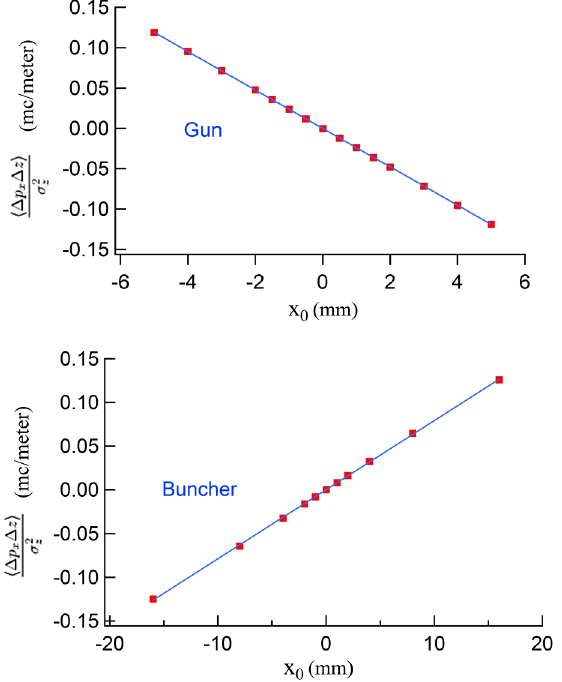
FIG. 2. z − p x correlation introduced by a rf cavity for different initial offsets. An initially uncorrelated beam enters each cavity with an initial horizontal offset x 0 . The final z − p x correlation is calculated at the exit of each cavity, using ASTRA simulation. The upper figure shows the correlation introduced by the rf gun and the lower shows the correlation introduced by the rf buncher cavity. The lines denote linear fits to the simulation data, with the slopes defining the correlation coefficients ( ∂ 2 p r = ∂ r ∂ z ).